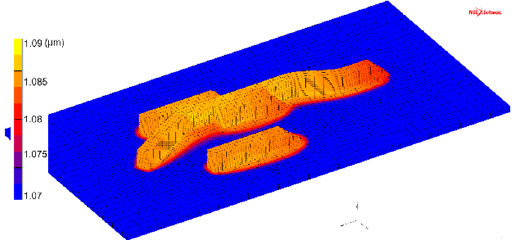
Figure 9. Simulated α lath thickness (µm) variation in the additive manufactured part.